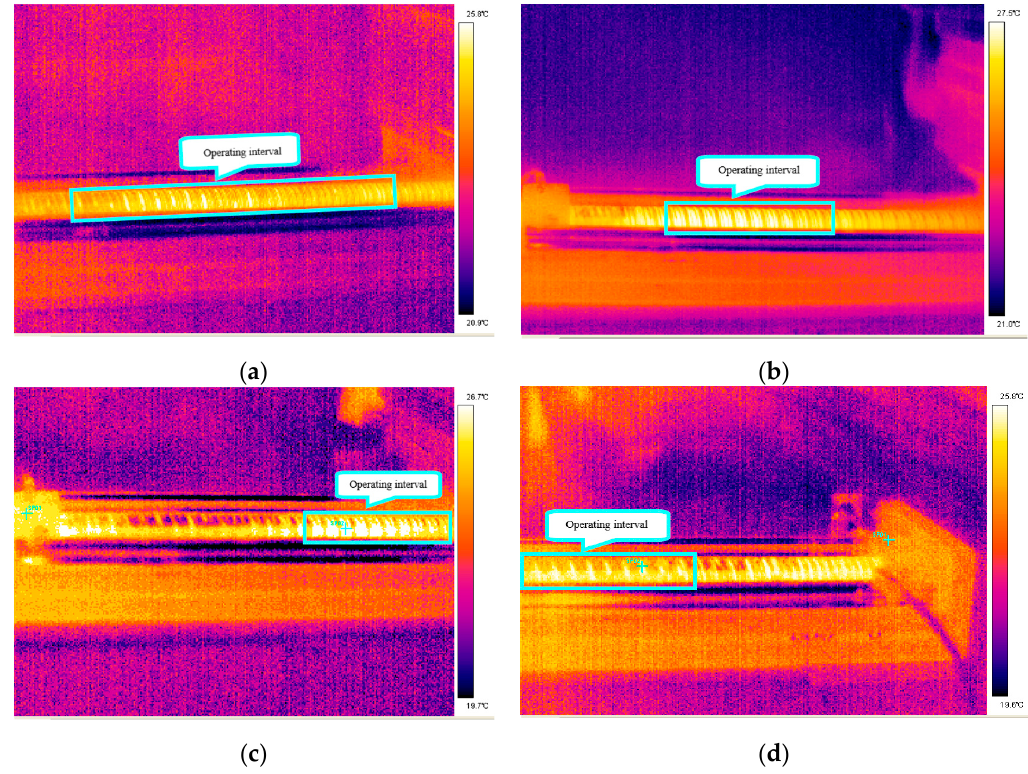
Figure 10. Temperature experimental results of the ball screw feed system under different working conditions: ( a ) working condition 1; ( b ) working condition 2; ( c ) working condition 3; and ( d ) working condition 4.